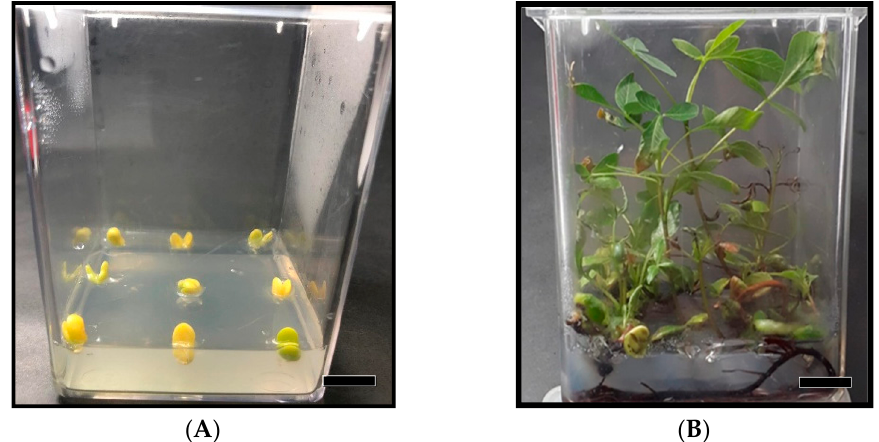
Figure 2. ( A ) Pistacia khinjuk Stocks seeds germinating in vitro in MS medium without any plant growth regulators (PGRs) ( B ) Proliferated plantlets in MS medium supplemented with 1 mg/L BAP; Bar: 0.90